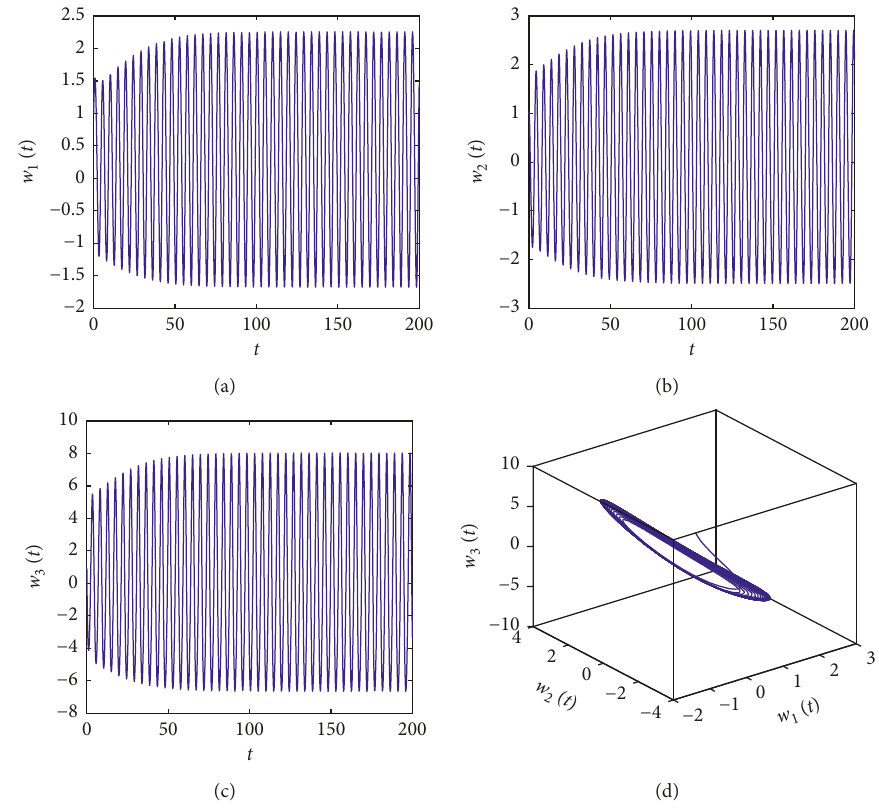
Figure 7: Computer simulations of model (70) when ρ